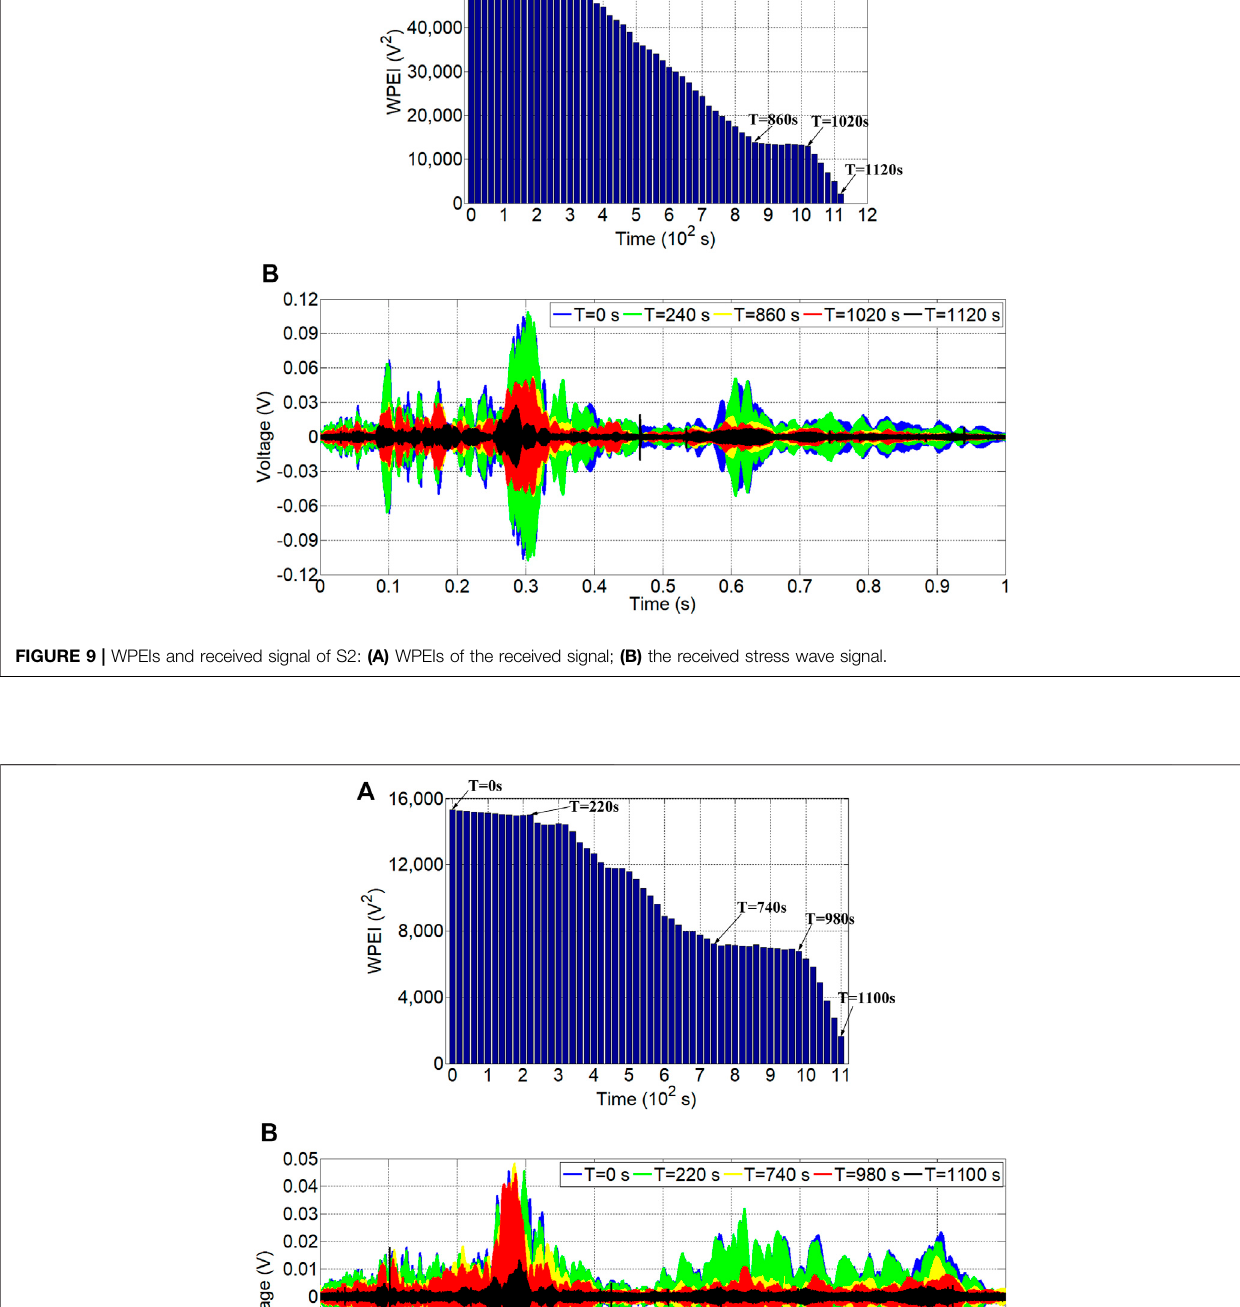
Frontiers in Materials |